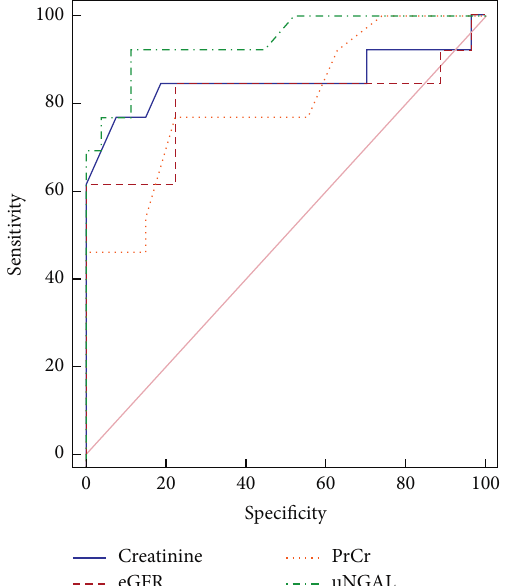
Figure 1: Graph ROC curves showing area under the curve of baseline UNGAL and conventional biomarkers to predict renal response to induction. It showed an AUC value of 0.943, outperforming conventional Table 6: Comparison between complete responders with partial and nonresponders as regards three-month follow-up renal biomarkers. Variable